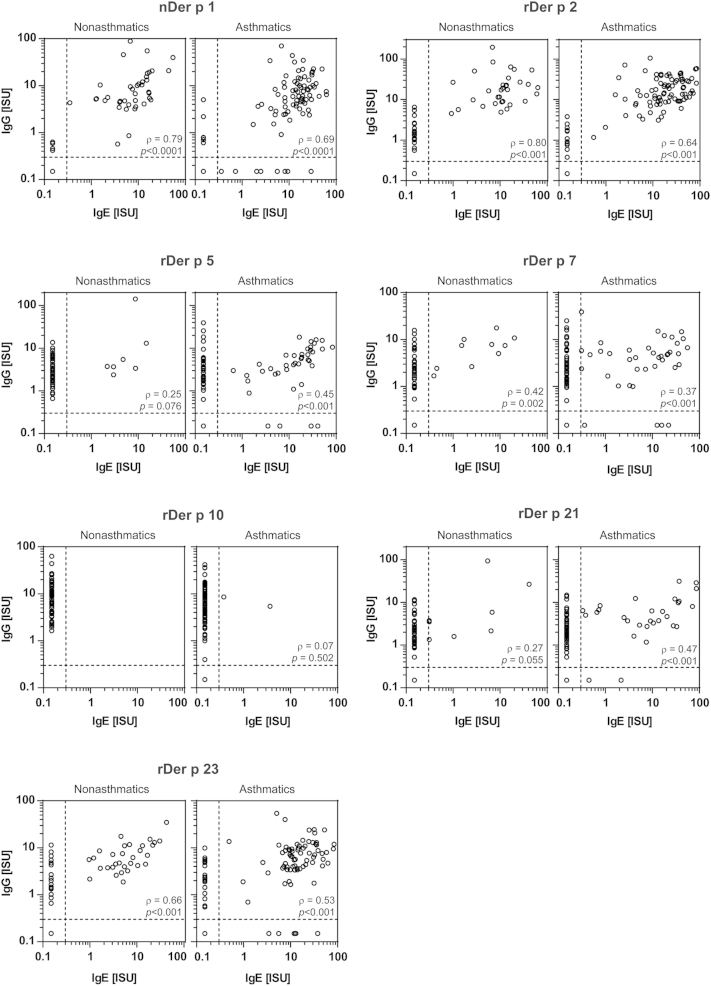
Correlations between IgE (x-axes) and IgG (y-axes) antibody levels to individual allergens for nonasthmatic (left panels) and asthmatic (right panels) children with HDM allergy are displayed as scatter plots. IgE- and/or IgG-negative values are depicted as 0.15 ISU (half of the cutoff value) to allow a log-scale presentation of the data. The correlation coefficient ρ and levels of significance (P values) are shown in the lower right corner of the graphs.